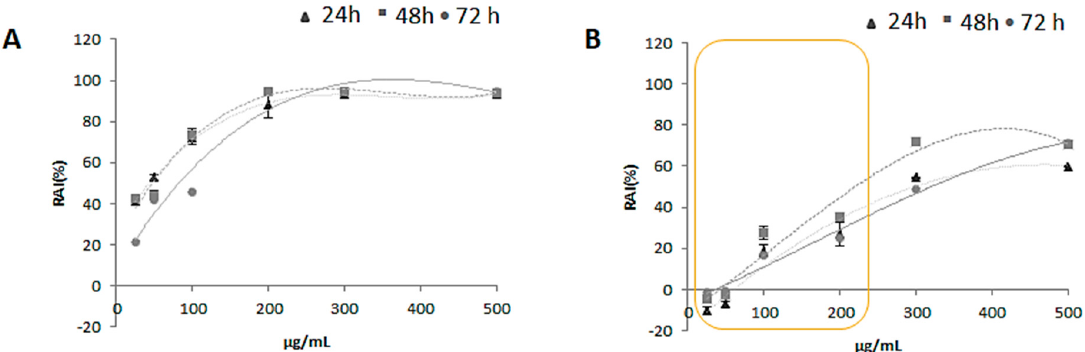
Figure 5. Mitochondrial redox activity inhibition (RAI %) estimated by MTT test in HaCat cell line treated with increasing doses (25.0, 50.0, 100.0, 200.0, 300.0 and 500.0 µ g / mL) of ( A ) ZLF-O and ( B ) ZLF-A extracts. Values, reported as percentage vs. an untreated control, represent mean ± standard deviation (SD) of measurements carried out in 3 samples (n = 3) analyzed twelve times.